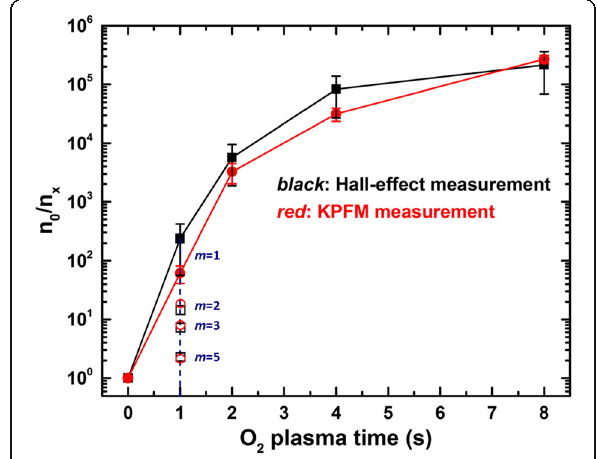
Fig. 5 Hall effect and KPFM measurement results of carrier concentration ratios between ZnO films grown with varying O 2 plasma times (solid dots) and thermal cycles (open